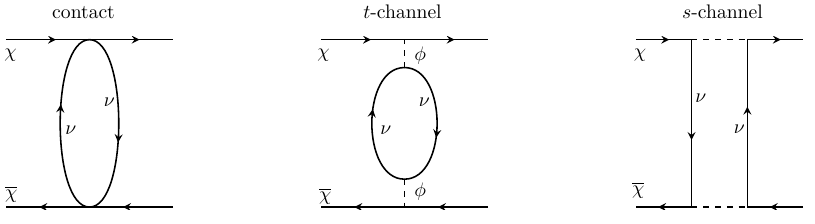
Figure 2 . Feynman diagrams of neutrino forces arising from contact (left), t -channel (middle), and s -channel (right)